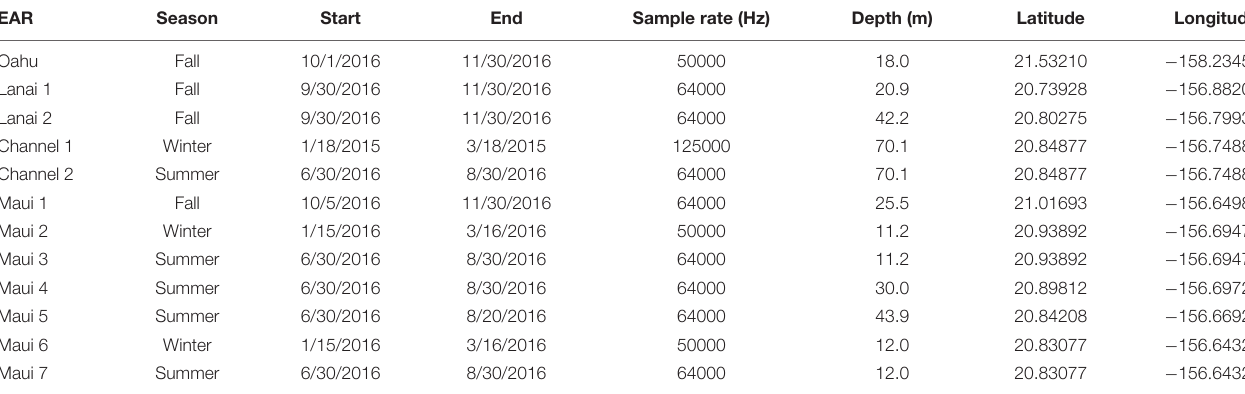
TABLE 1 | Ecological Acoustic Recorders (EARs) were deployed in one location off O‘ahu, and eight locations in Maui Nui. EAR Season Start End Sample rate (Hz) Depth (m) Latitude Longitude Oahu